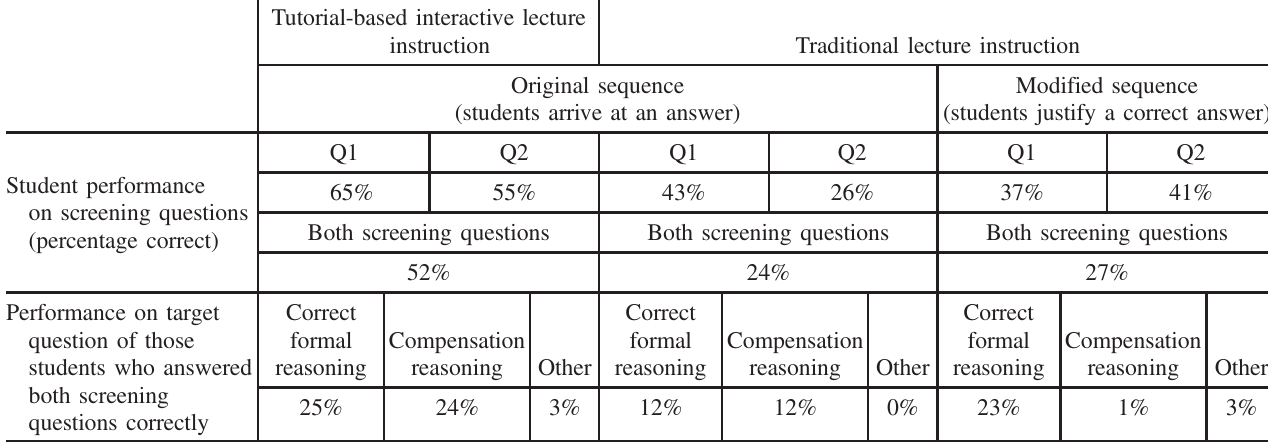
TABLE I. Student performance on the capacitors sequence. (All reported percentages are percentages of